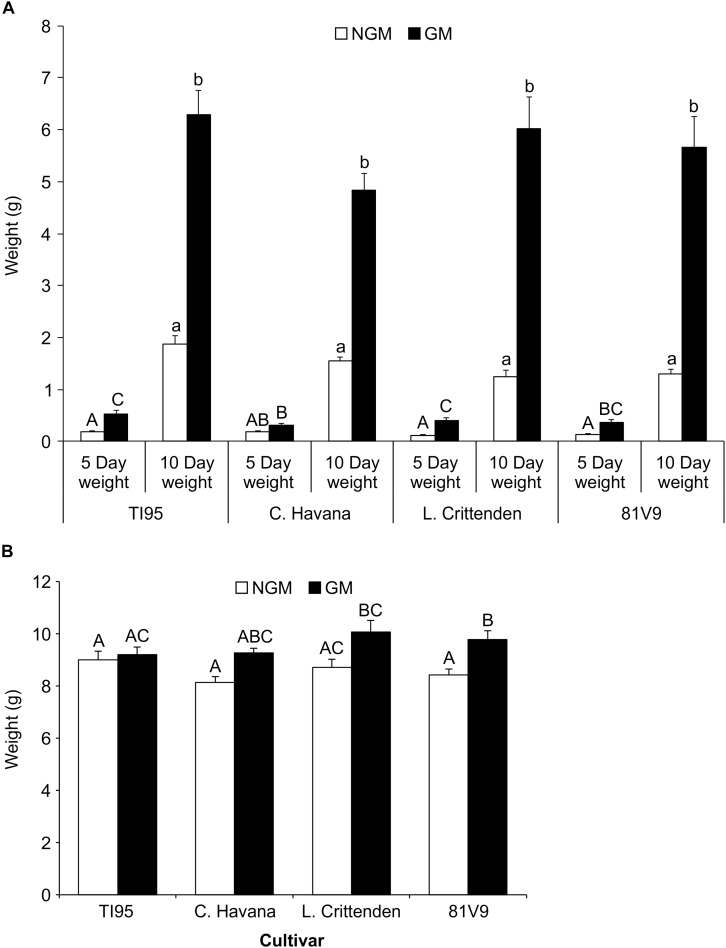
Tobacco hornworm larvae gain more weight on greenhouse-grown transgenic lines when younger, but even-out by the pre-pupal stage. Mean larval weights ± S.E. of tobacco hornworm larvae fed on greenhouse grown, non-transgenic and transgenic tobacco cultivars (N = 20 larvae/cultivar). (A) 5 and 10 days old larvae and (B) pre-pupal larvae (after approximately 20 days). Bars with the same uppercase (5 days weights) or lowercase (10 days weights) letter in (A) are not statistically different, while bars with the same uppercase letter in (B) indicates no statistical difference (2-way ANOVA, Tukey’s pairwise comparison, P < 0.05).